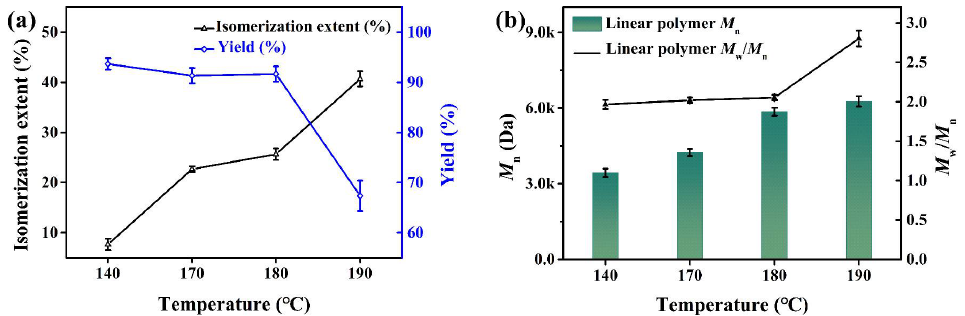
Figure 3. Effect of reaction temperatures on the isomerization extent and yield ( a ), M n and M w / M n ( b ) of